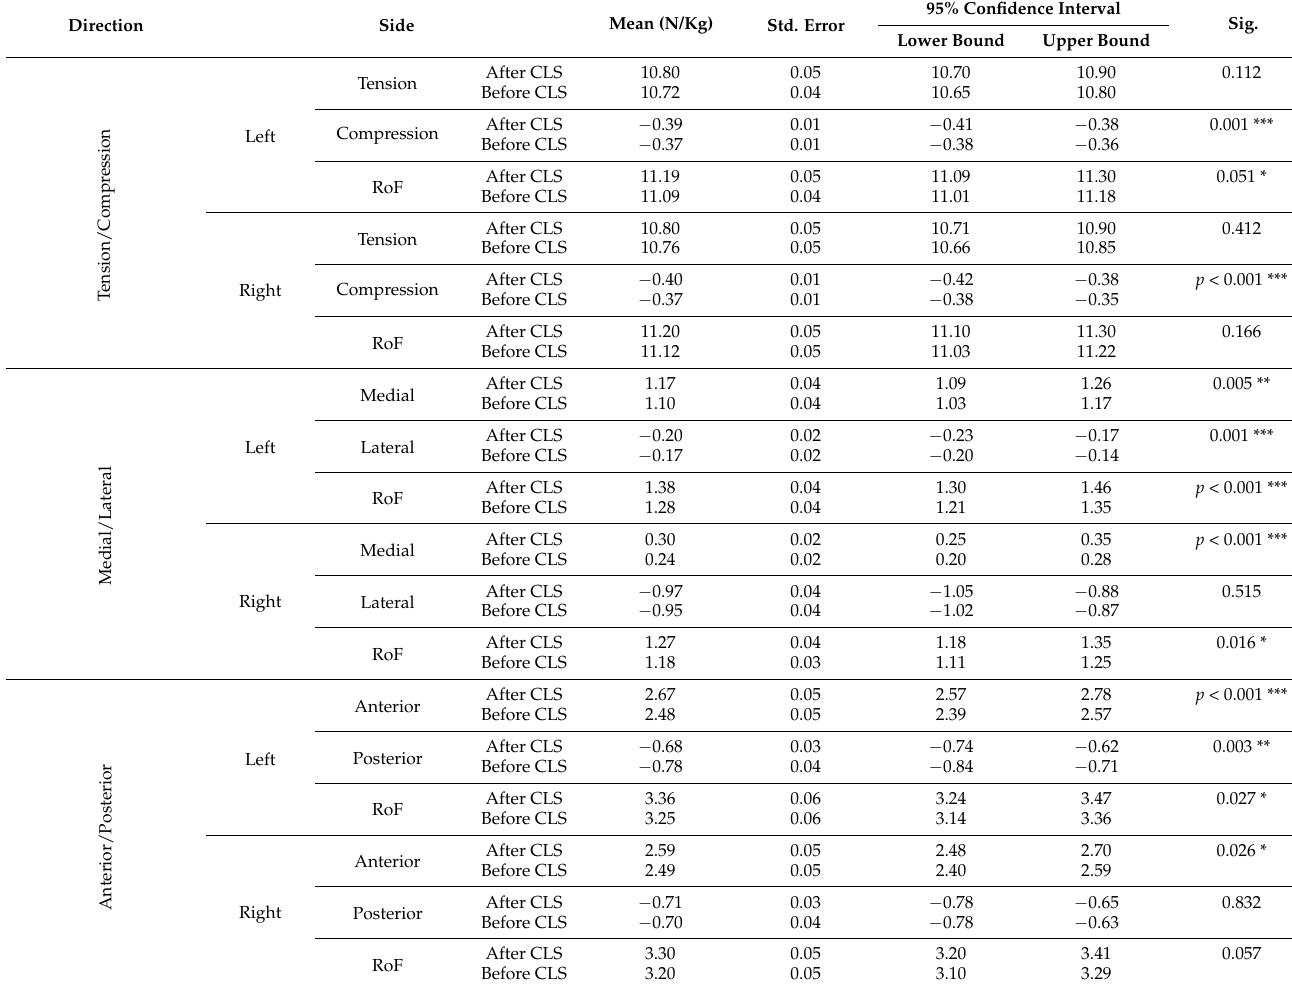
Table 8. Ankle Joint Force in Anterior/Posterior, Medial/Lateral, and Tension/Compression